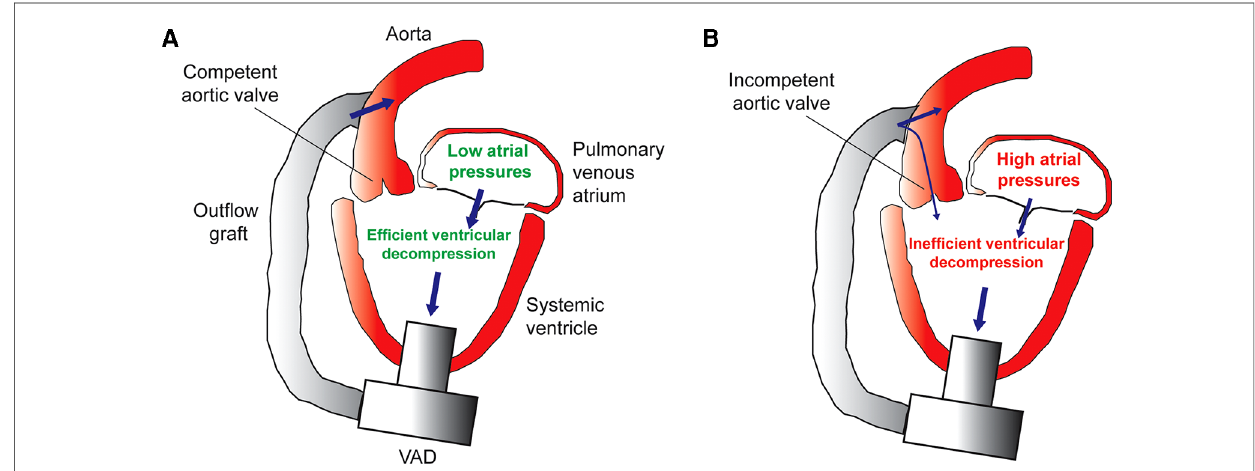
FIGURE 1 ( A ) Ef fi cient decompression of the systemic ventricle and pulmonary venous atrium in the setting of a competent aortic valve. ( B ) Inef fi cient VAD support caused by aortic insuf fi ciency leads to incomplete ventricle decompression, high atrial pressures, pulmonary venous congestion, and heart failure